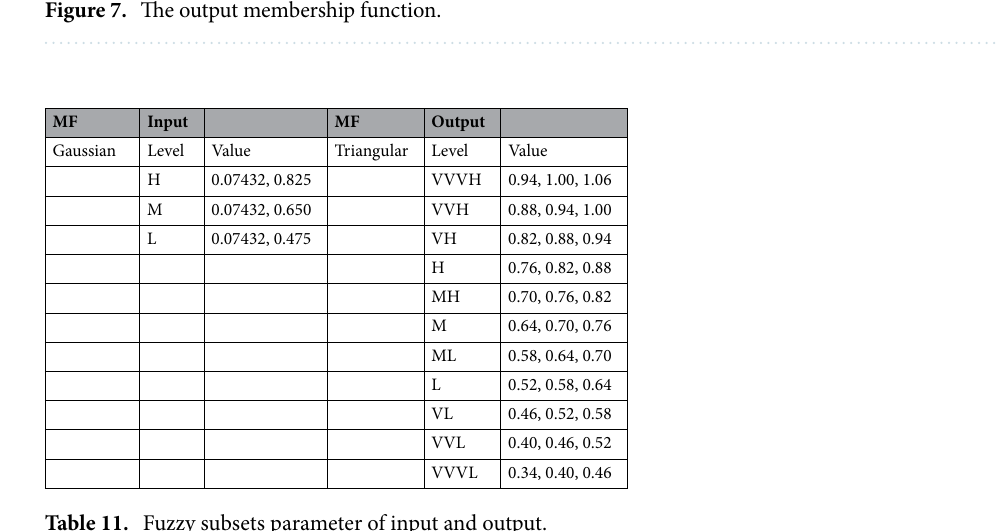
optimization objectives (RSS, RSC, WS, WC and RFM) and fuzzy subset grades of input (H, M and L) is shown in Table 12. The weight values of the fuzzy subset grades on the input for each optimization objective are shown in Table 13. Namely, the weights of H, M and L grades on the fuzzy subset for RSS and RSC are 0.1250, 0.0625 and 0, respectively; the weights of H, M and L grades on the fuzzy subset for WS and WC are 0.1750, 0.0875 and 0, respectively; the weights of H, M and L grades on the fuzzy subset for RFM are 0.4000, 0.2000 and 0, respectively. The values and the fuzzy subset grades of output are shown in Table 14. Namely, the corresponding values the comprehensive weight value and the grades of corresponding output fuzzy subsets are shown in Table 15 (the “CV” column is the comprehensive weight). The final fuzzy rule scheme of this study is as follows: Rule 1 : if " RSS is H and RSC is H and WS is H and WC is H and RFM is H " then " GF is VVVH " ; else